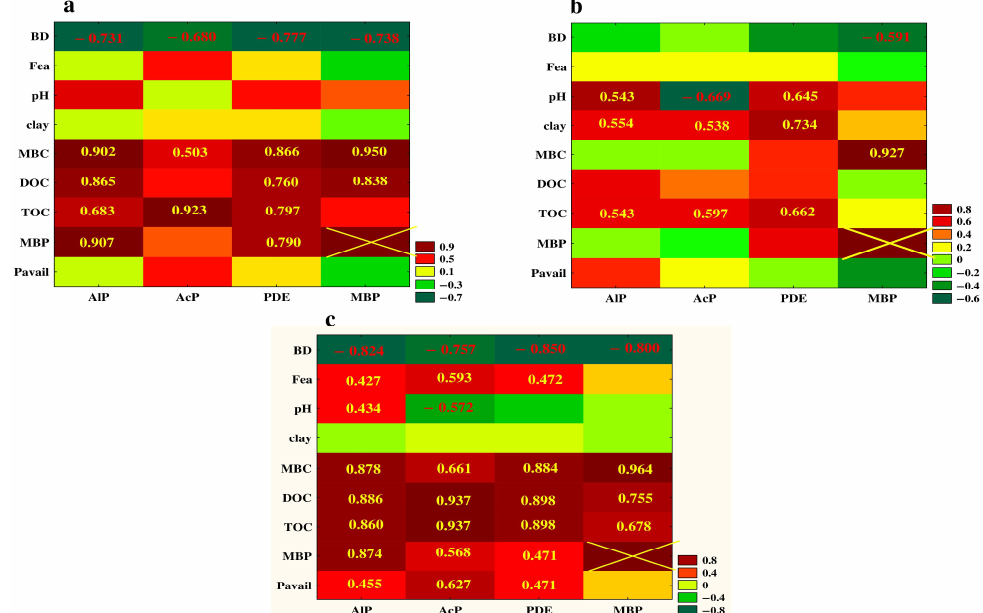
Figure 5. Heatmaps of correlations between studied properties (all profiles are considered together), horizons with TOC >0.5% ( a ), horizons with TOC,0.5% ( b ), all horizons ( c ) Only significant values are presented ( p < 0.05), AlP—alkaline phosphatase, AcP—acid phosphatase,